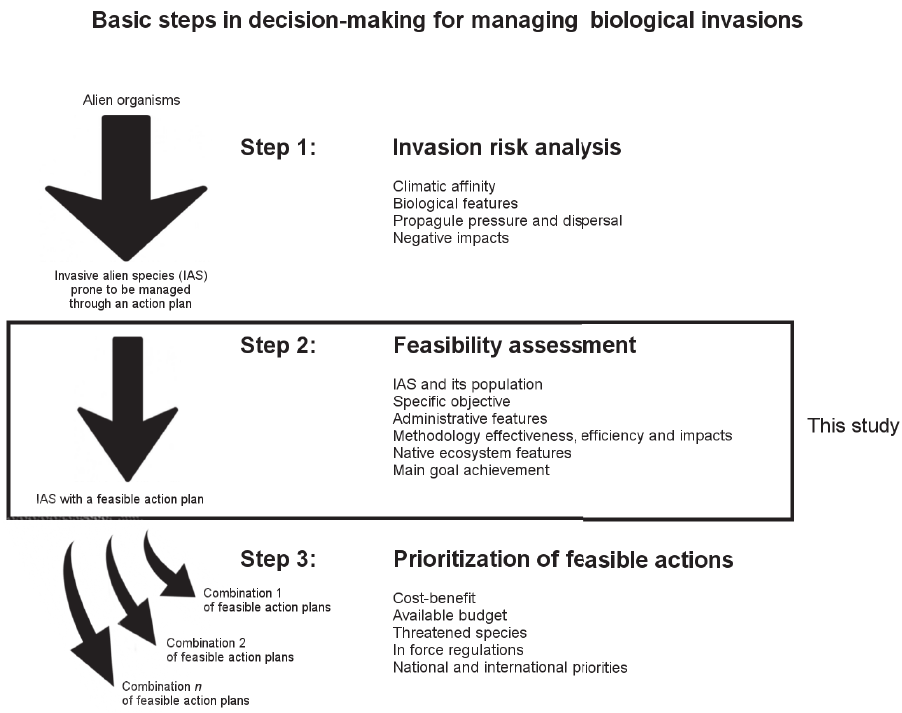
Figure 4. Basic steps in decision-making for managing biological invasions. The checklist proposed in this study focuses on step